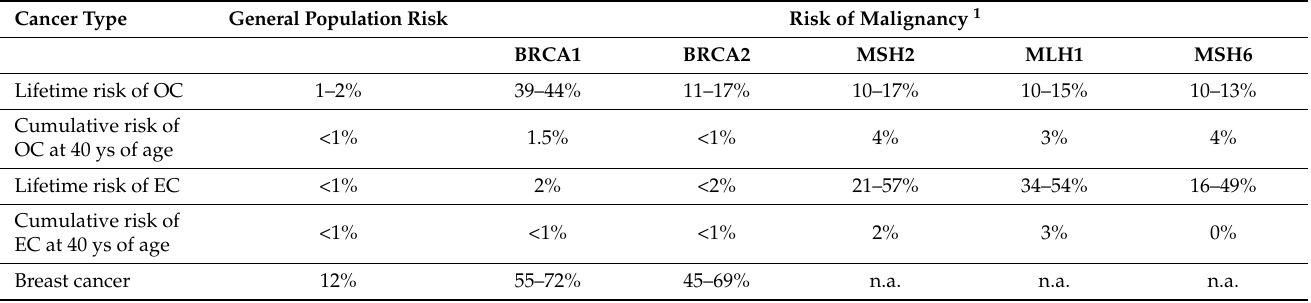
Table 1. Risk of malignancy in individuals with/without a germline pathogenic